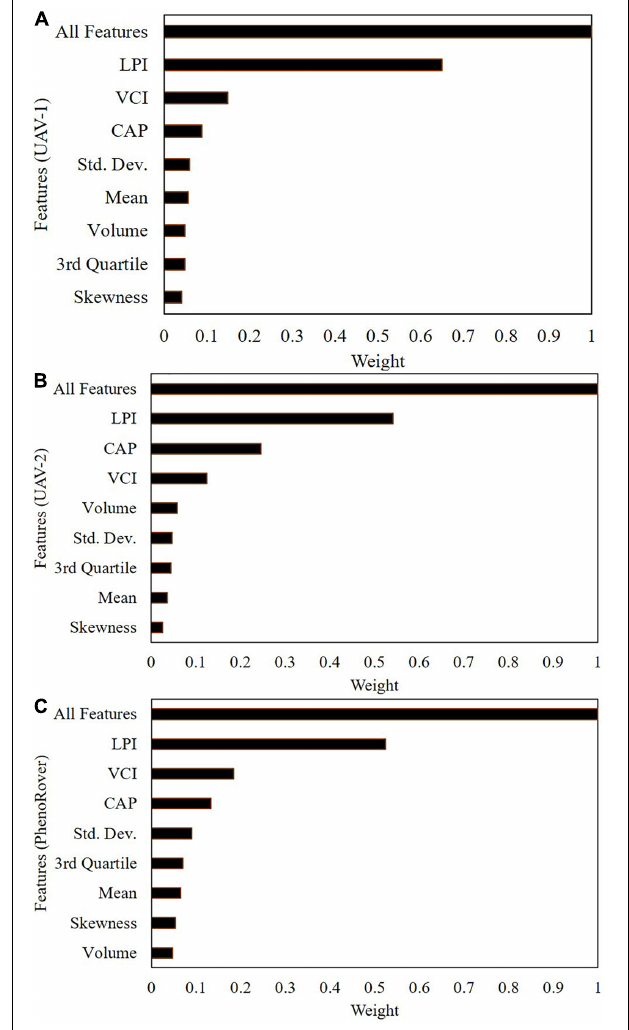
FIGURE 13 | Feature weight evaluation using SVR (RBF) on 7/20/2020: (A) UAV-1, (B) UAV-2, (C)